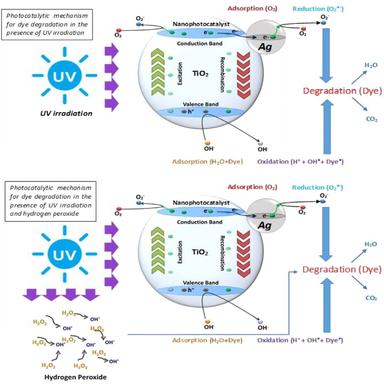
Dye removal kinetic results for DR-80 by hydrogen peroxide-assisted photocatalytic degradation, UV photocatalytic degradation, catalytic hydrogen peroxide oxidation, and adsorption processes, respectively (10 mg/L concentration, 0.03 g nanocomposite, 120 min).